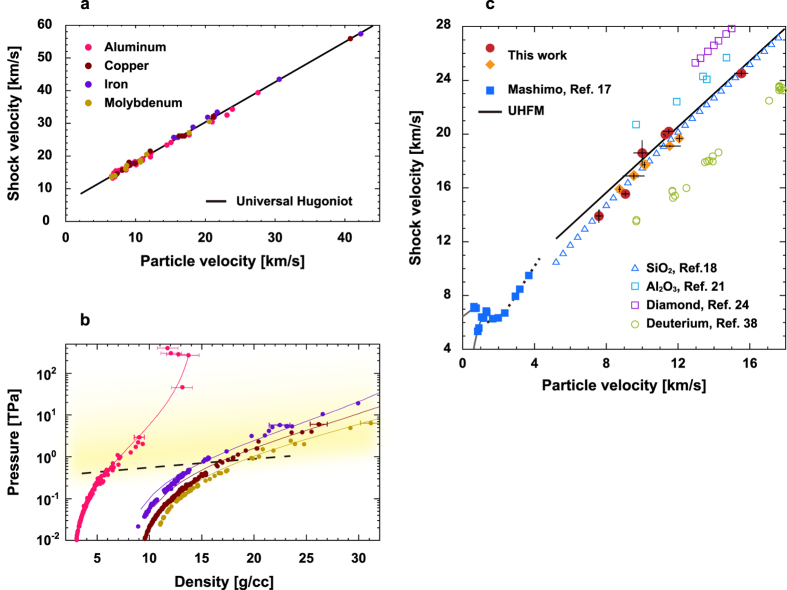
Universal Hugoniot of fluid metals.Universal Hugoniot of fluid metals (a) in the Us vs. up (solid line) and (b) in the P vs. ρ from previously published data for Al, Cu, Fe, and Mo. In Fig. 2(a), shock pressures corresponding to shock velocities near 60 km/s are ~20 TPa. (c) Hugoniot data of GGG and the UHFM line. Red circles and orange diamonds are our laser data and Z data, respectively. Solid blue squares signify data from gas-gun experiments17. The solid straight line above up = 5 km/s is the UHFM line9, and the open triangles from the Hugoniot of α-quartz (SiO2) from the Z experiments18. The GGG data, as well as the SiO2, are reasonably consistent with the UHFM. D2 (open green circles)38, Al2O3 (open blue squares)21, and diamond (open purple squares)24 are typical exceptions.